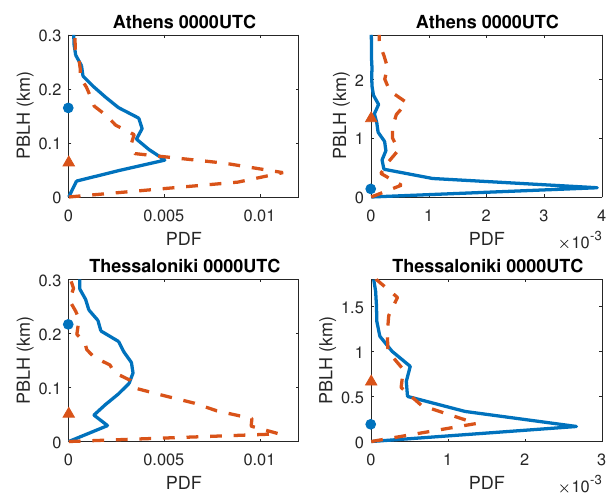
Figure 8. Left panels: Probability Density Function (PDF) of the PBLH estimated from the 0000UTC soundings using the gradient (solid lines) and the bulk Richardson number (dashed lines) methods as well as the corresponding median values of the distributions for the gradient (circles) and the bulk Richardson number (triangles) methods. Right panels: PDF of the PBLH estimated from the 0000UTC soundings using the gradient method for the SBL (solid lines) and the NBL (dashed lines) types as well as the corresponding median values of the distributions for the SBL (circles) and the NBL (triangles)